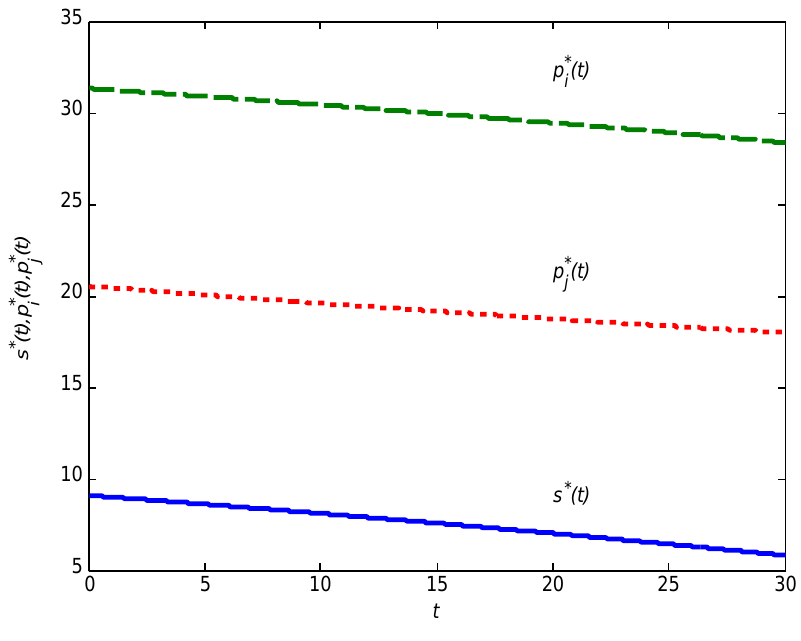
Figure 1. Optimal price and subsidy trajectories over time